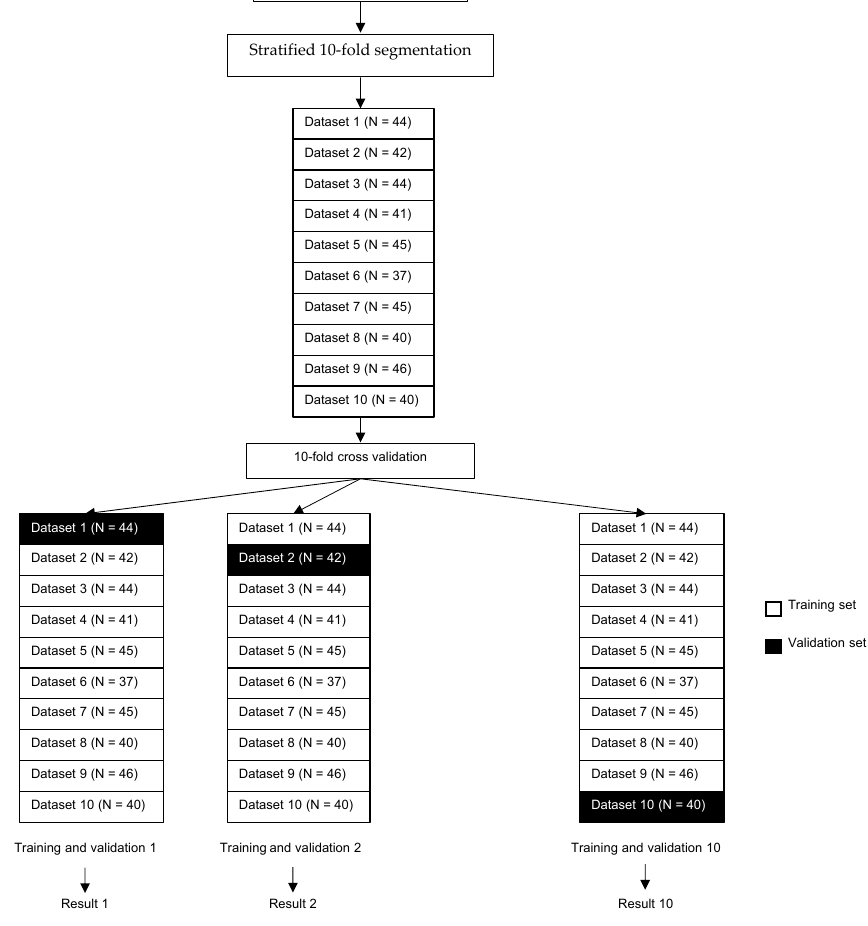
Figure 2. Illustration of the 10-fold cross-validation process. Legend: For the 10-fold cross validation, 10 sub datasets were used and for each of the 10 training and validation procedures, training was performed on 9 sub datasets (white boxes) and tested on the remaining sub dataset (black box). The subset used for testing changed between each procedure. Average accuracy and agreement compared with a vascular physician (physician 1) were